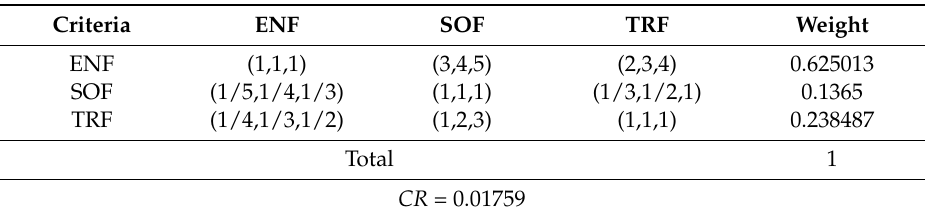
Table A1. Comparison matrix for